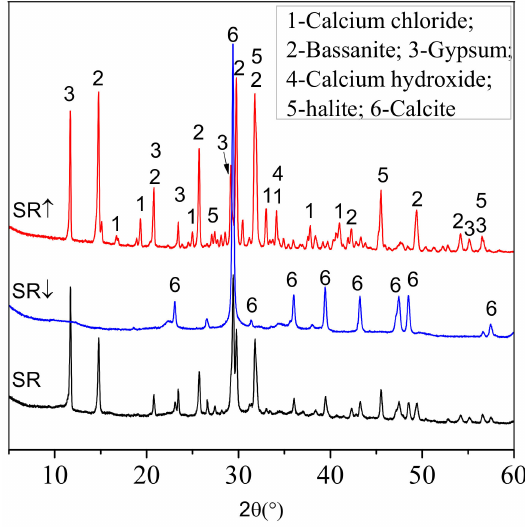
Figure 1. XRD patents of supernatant (SR ↑ ), precipitation (SR ↓ ), and SR. SR was mixed with water in mass ratios of 1:10 to 1:400. The pH value and chloride ion concentration of its supernatant were tested. As Figure 2 shows, the average dissolution rate of chloride and pH value vary with the mass ratio of water to SR. As mass ratio of water to SR increases, the dissolution rate of chloride ion rises. When mass ratio of water to SR is 50:1, the dissolution rate of chloride ion is 77.7%. When the mass ratio of water to SR reaches 300:1, dissolution rate of chloride ion is 100%, indicating that a large amount of water is needed to dissolve all the chloride ion in the SR. The pH value firstly increases and then decreases. The maximum pH value of supernatant is 12.04 when water to SR mass ratio is 40:1. The solution of SR is still in a high alkaline environment (pH value > 11.4) when the mass ratio of water to SR is 400:1.